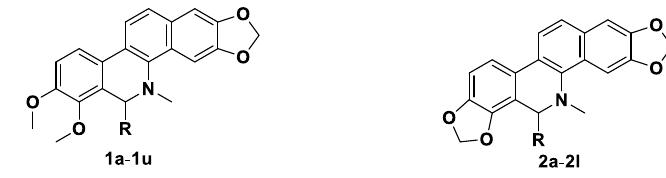
Table 1. IC 50 values of 33 derivatives against leukemia cell lines in vitro ( x ± SD, n = 3). Compound